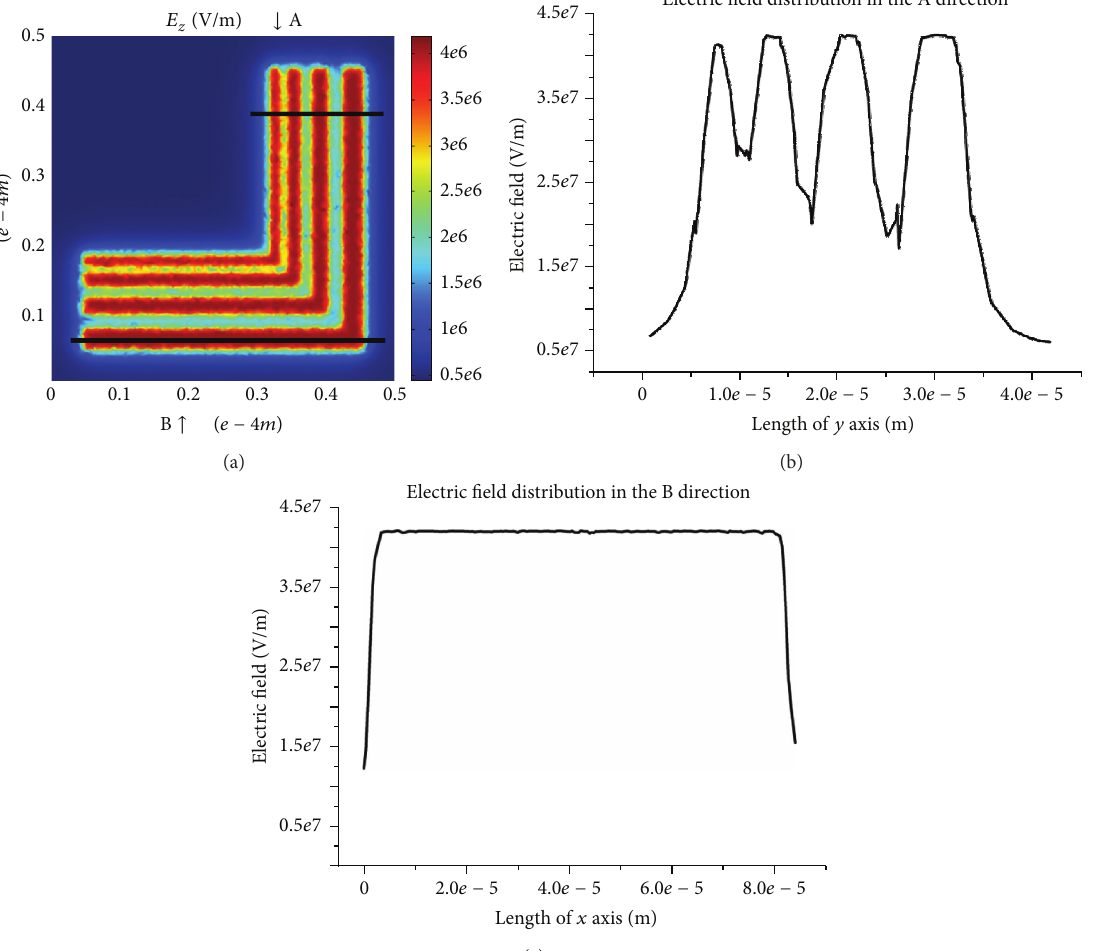
Figure 3: (a) 𝑍 component of the electric field on the surface of polymer film in initial phase, (b) A direction: the cross section of the L-shaped line, and (c) B direction: in axial direction of L-shaped line.